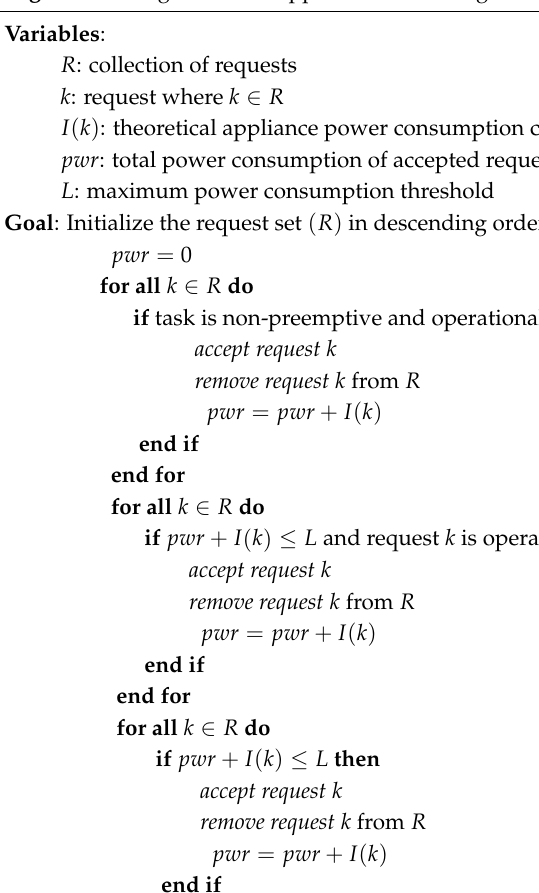
Algorithm 1 Algorithm for appliance